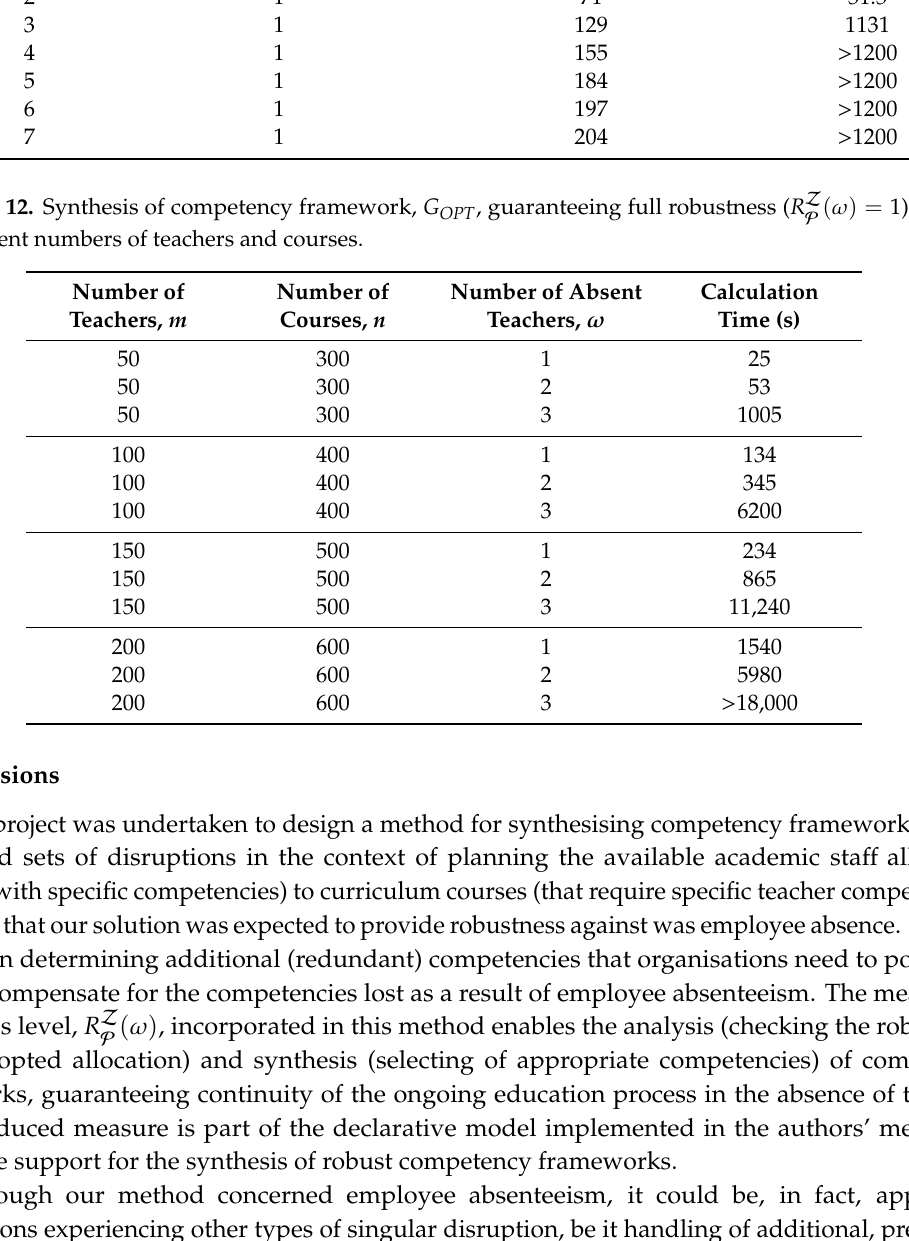
Table 11. Synthesis of competency framework, G OPT , under robustness level condition R assumed on ω teacher absenteeism while taking into account the employment of additional sta ff .